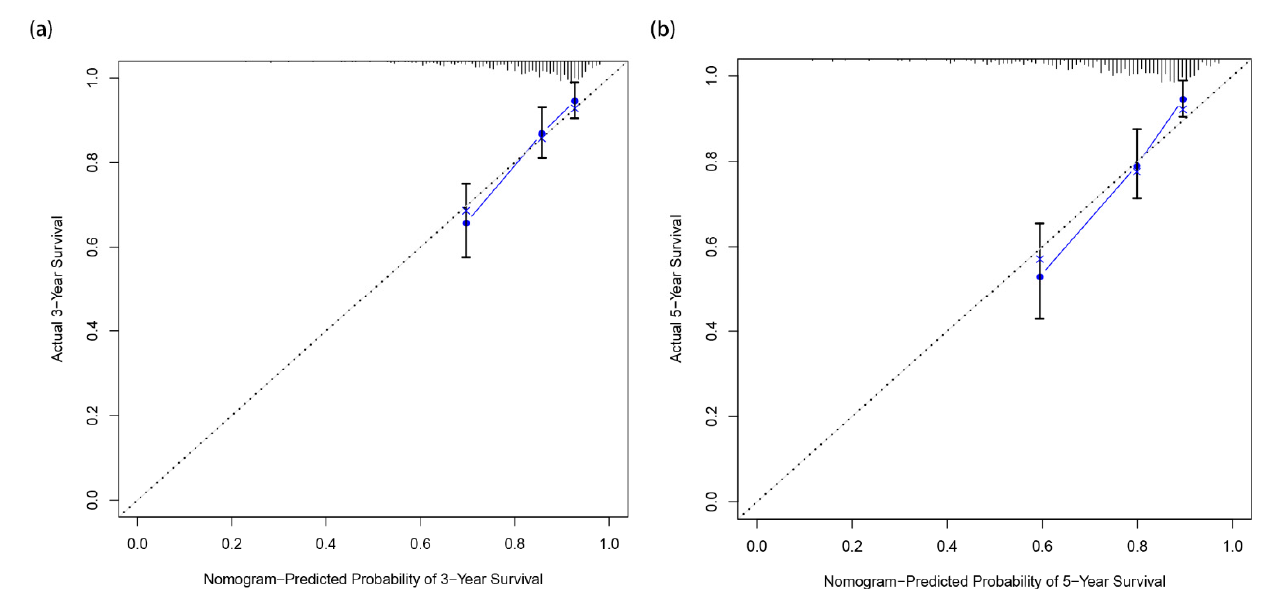
Figure 5. ( a ) Calibration curves of EC patient risk signature used for evaluating the 3- year AUC. ( b ) Calibration curves of EC patient risk signature used for evaluating the b- year AUC.The x-axis is nomogram-predicted probability of survival, and the y-axis is actual survival. We used the bootstrapping method for the internal validation of the nomogram. The dotted line indicates perfect calibration, the blue line represents the actual predictive power of the model, the closer the blue line is to the dotted line, the higher the accuracy of the prediction.